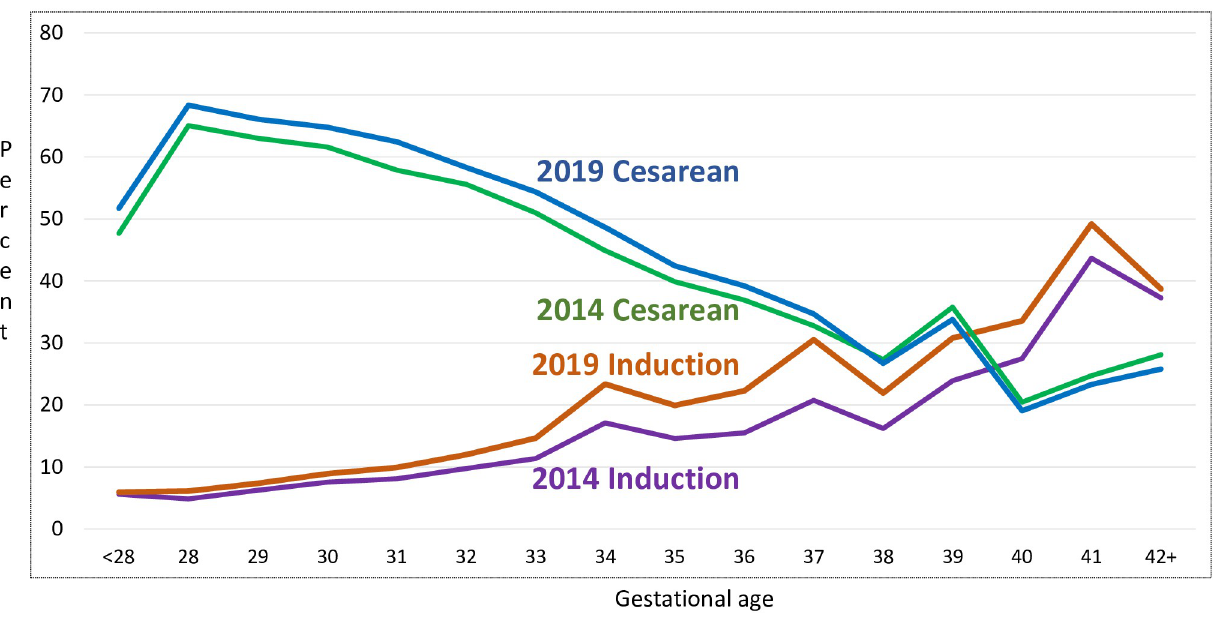
Fig 1. Percentage of singleton births with cesarean or induction by gestational age, United States, 2014 and 2019.